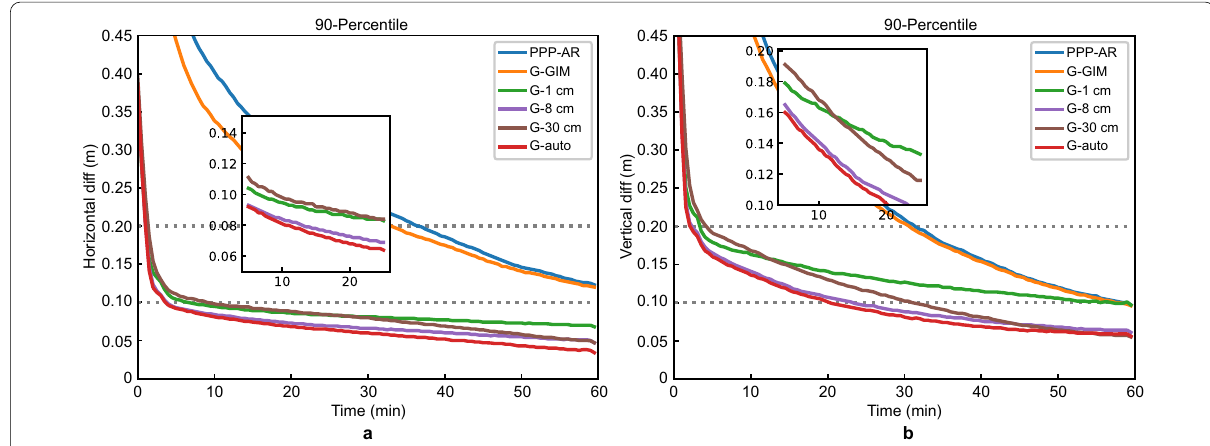
Fig. 6 The time series of the 90th percentile of horizontal ( a ) and vertical ( b ) positioning error of five groups of GPS PPP